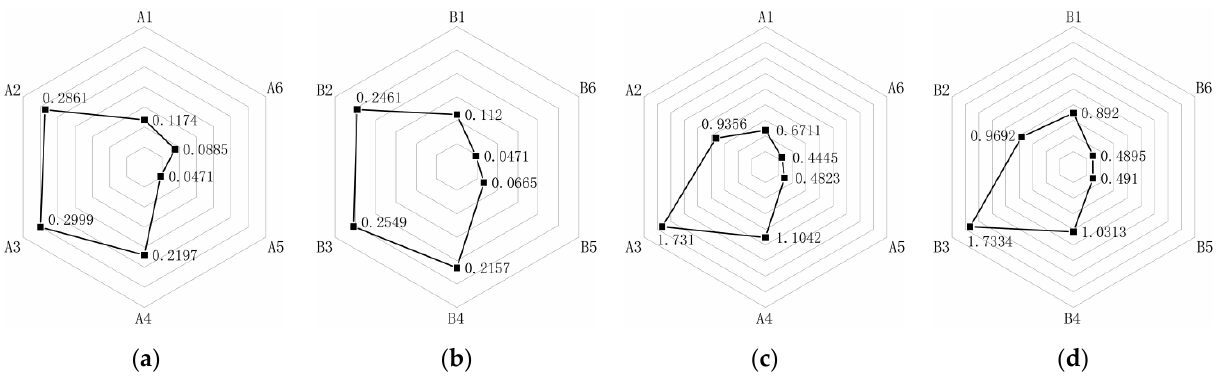
Figure 11. PPD (mm) during single-train traffic: ( a ) PPHD of double-track tunnel; ( b ) PPHD of double-track tunnel with middle partition wall; ( c ) PPVD of double-track tunnel; ( d ) PPVD of double-track tunnel with middle partition wall; A1-A6 and B1-B6 here correspond to that of A1-A6 and B1-B6 in Fig. 9.